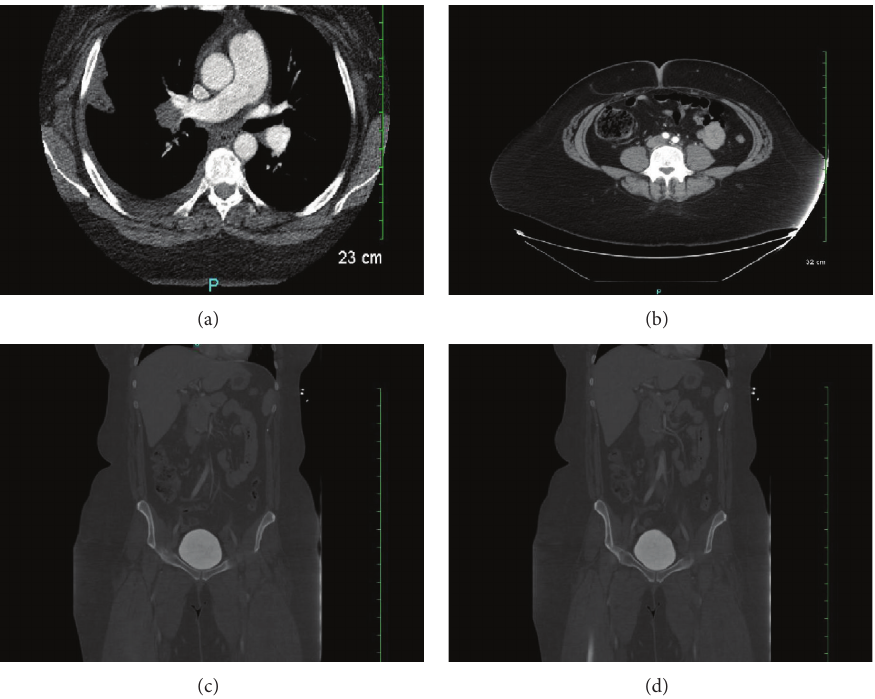
Figure 2: Massive bilateral PE noted in (a), right common iliac artery crossing in front of left common iliac vein noted in (b), (c), and (d), and features consistent with the May-Thurner syndrome.